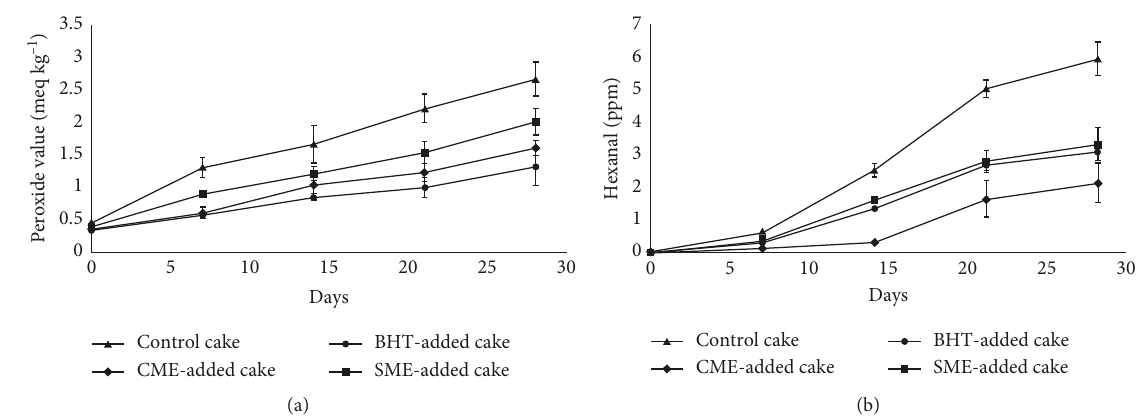
Figure 2: The effect of antioxidants on the formation of peroxides and hexanal in cake samples during storage at room temperature; (a) peroxide formation of cakes over time and (b) hexanal production in cakes over time. Each data point represents mean ± SD ( n �